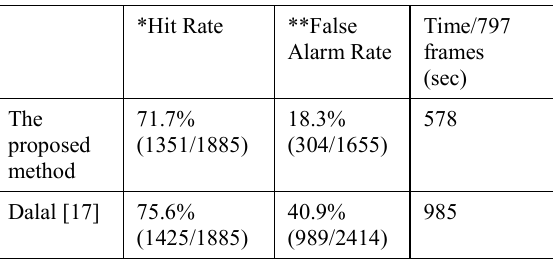
Time/797 Alarm Rate frames (sec)